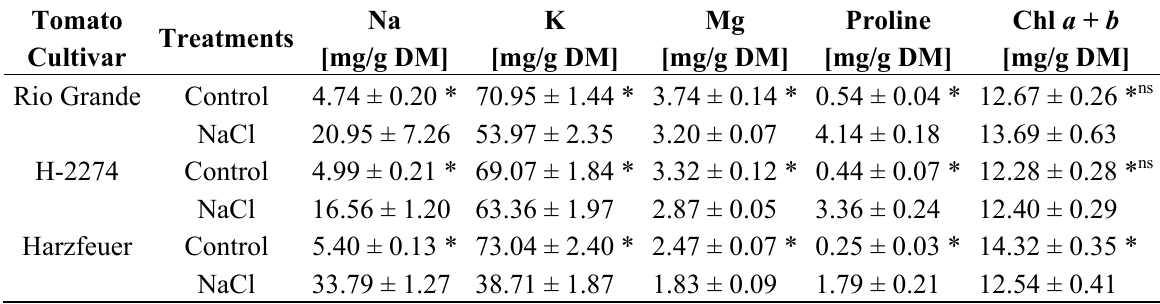
Table 1. Sodium, potassium, magnesium, proline and total Chl (Chl a + b ) concentrations in tomato leaves. Samples were taken 40 days after initiation of the